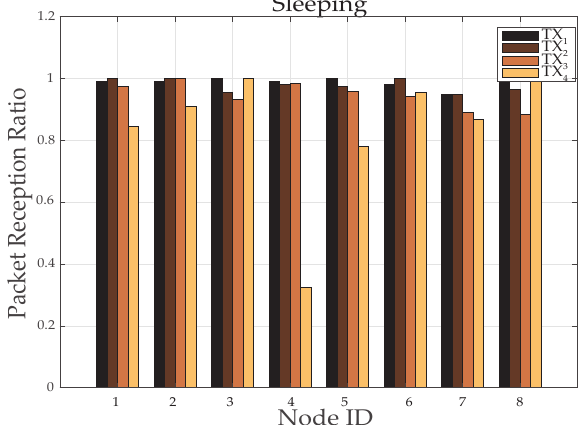
Figure 26. Packet Reception Ratio at various nodes while sleeping